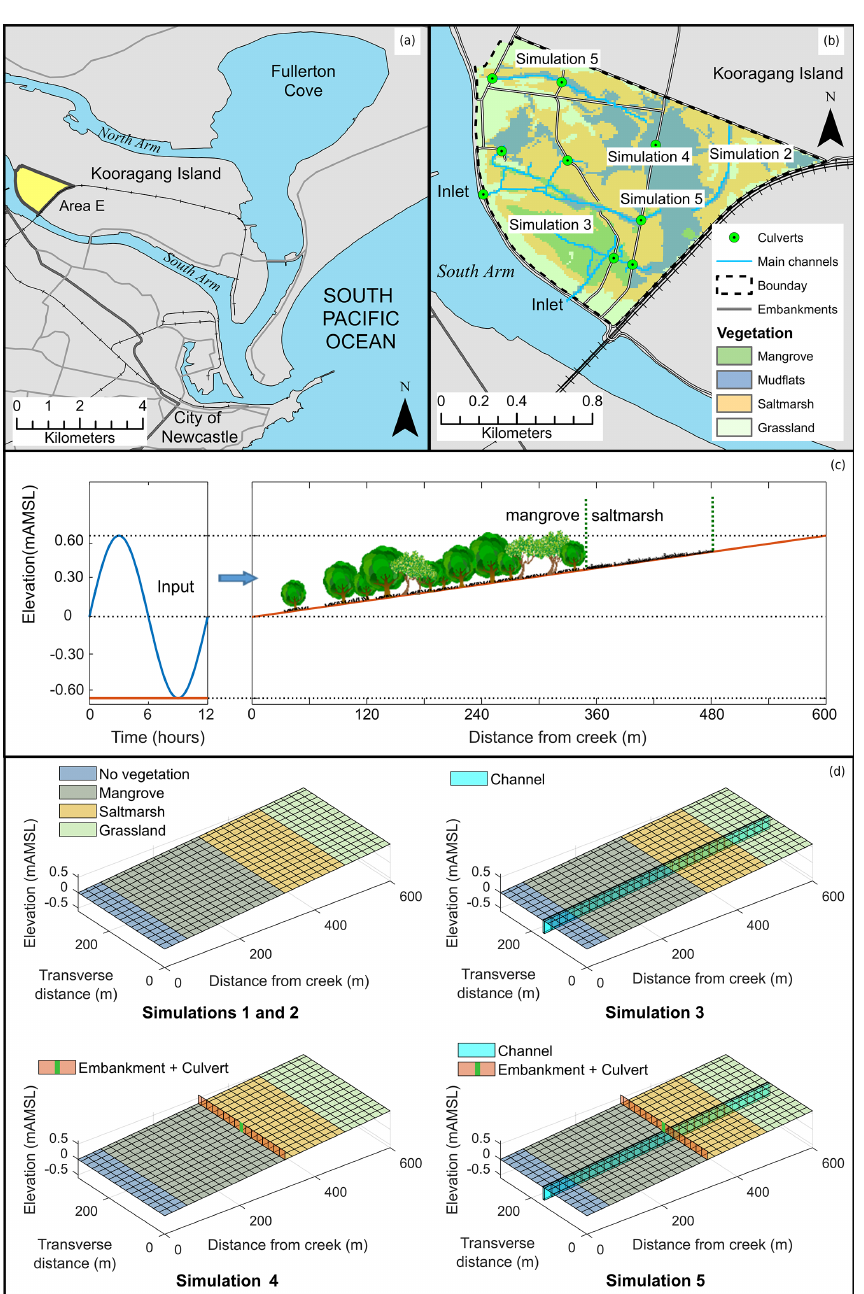
Figure 1. Field site and areas within the site characterised by the numerical simulations: (a) Area E of Kooragang wetlands, (b) areas within the wetland where the simplified simulations represent the dominant processes, (c) schematic longitudinal view of the domain setup and sinusoidal wave input (adapted from Rodriguez et al., 2017), and (d) schematic isometric view of each simulated domain and their hydraulic features. Vegetation cover is only indicative and roughly corresponds to early stages of the simulations. Elevation unit, mAMSL, stands for metres above mean sea